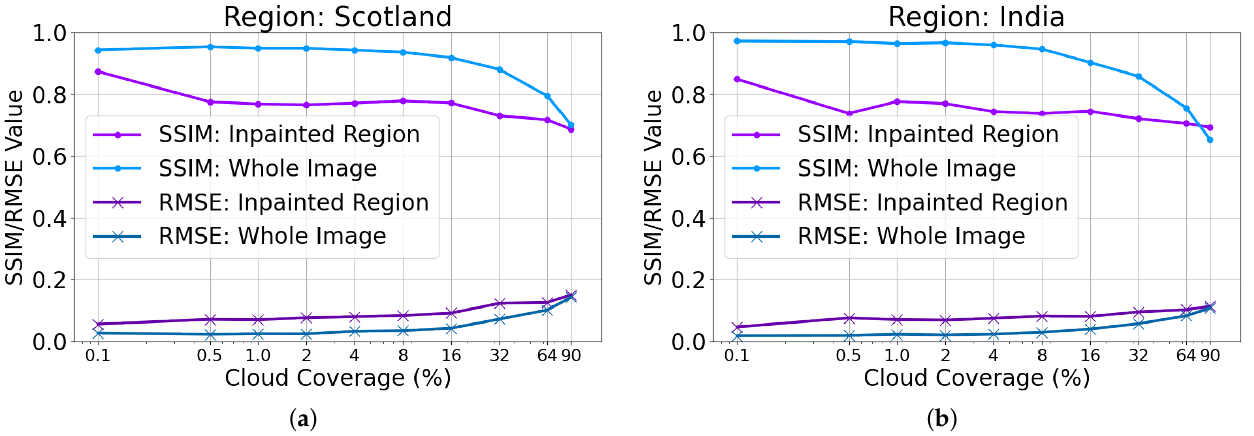
Figure 5. The inpainting quality appears to be consistent for cloud coverage ratio between 0.1% to 16%, where the inpainted region SSIM is approximately 0.75 for the Scotland and India regions. The SSIM decreased beyond 16% cloud coverage, however, but never fell below 0.6. Naturally, the whole-image SSIM was higher than that of the inpainted region since the whole image contained the noncovered region, which was optimised directly. The visual quality of the reconstruction of selected samples from each dataset for a range of cloud coverage levels is illustrated in Figure 6.